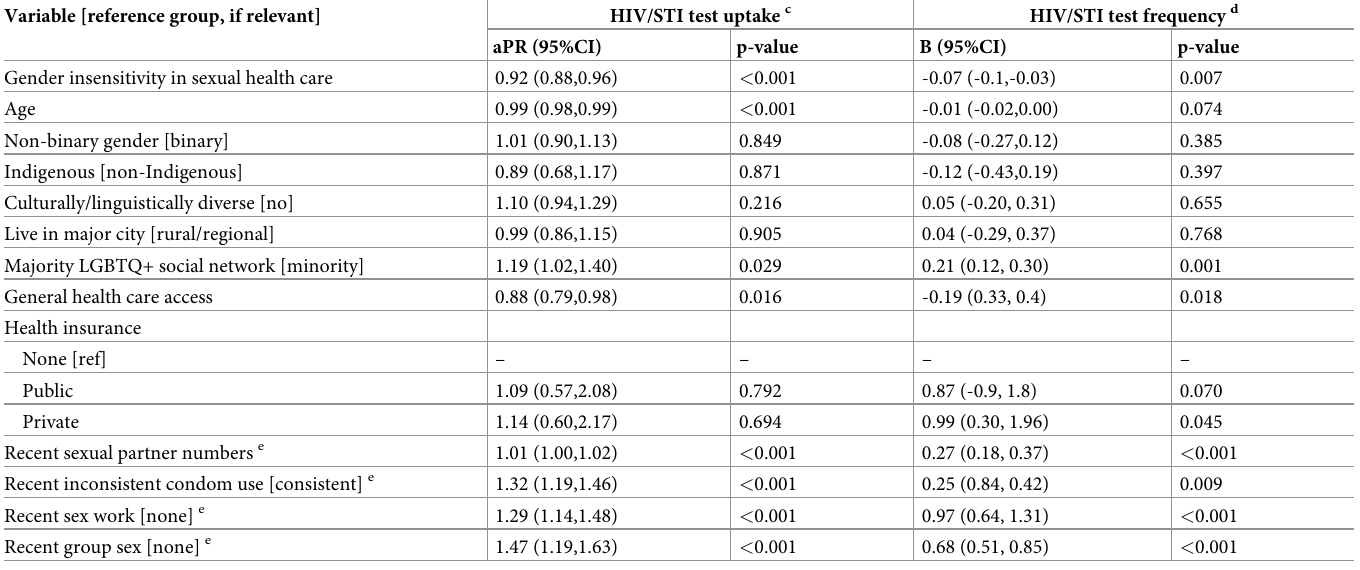
Table 4. Results of generalized linear regression analyses investigating associations between gender insensitivity a and HIV/STI testing among sexually active trans and gender diverse people in Australia (n = 1,175) b . Variable [reference group, if